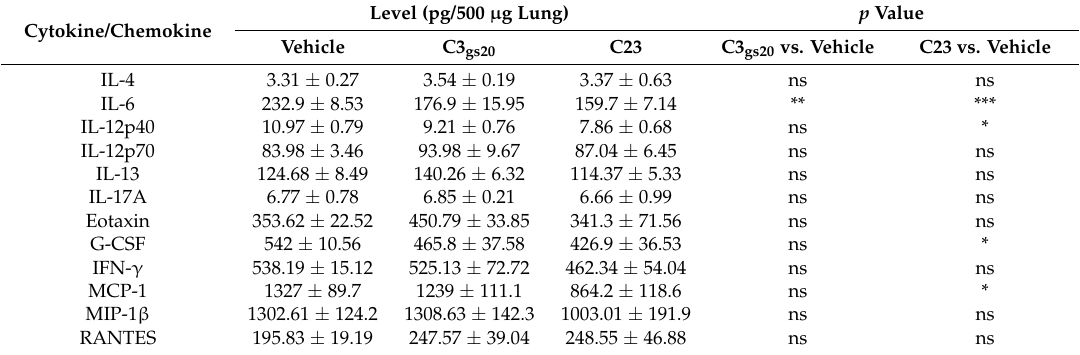
Table 2. Levels of cytokines and chemokines in murine lungs during acute P. aeruginosa lung infection (6 h) and subcutaneous treatment with C3 gs20 or C23 (30 mg/kg).